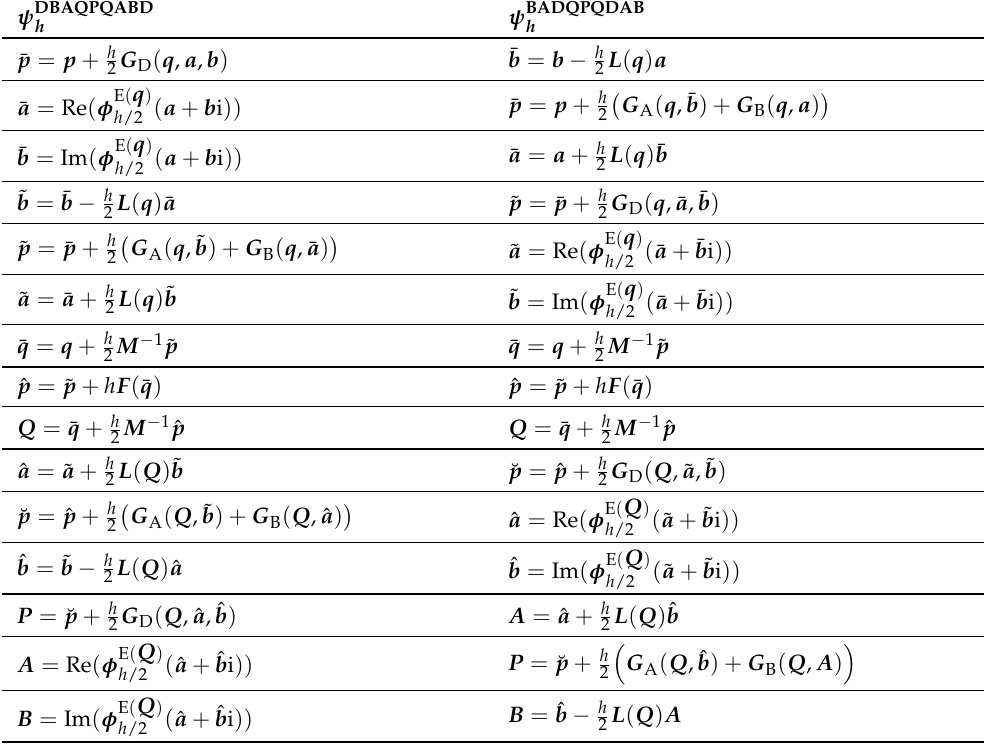
Table A5. Explicit representations of explicit numerical flow maps ψ DBAQPQABD